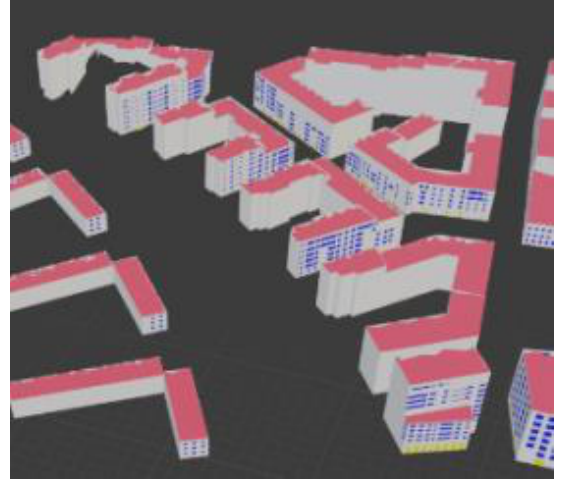
Figure 5. 3D building objects in the study area.